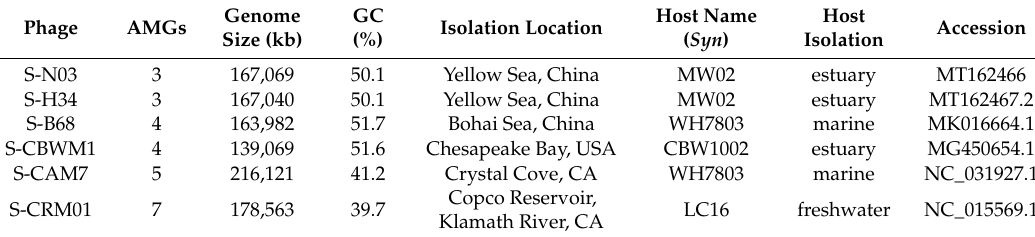
Table 4. Information of cyanophages with AMG content less than